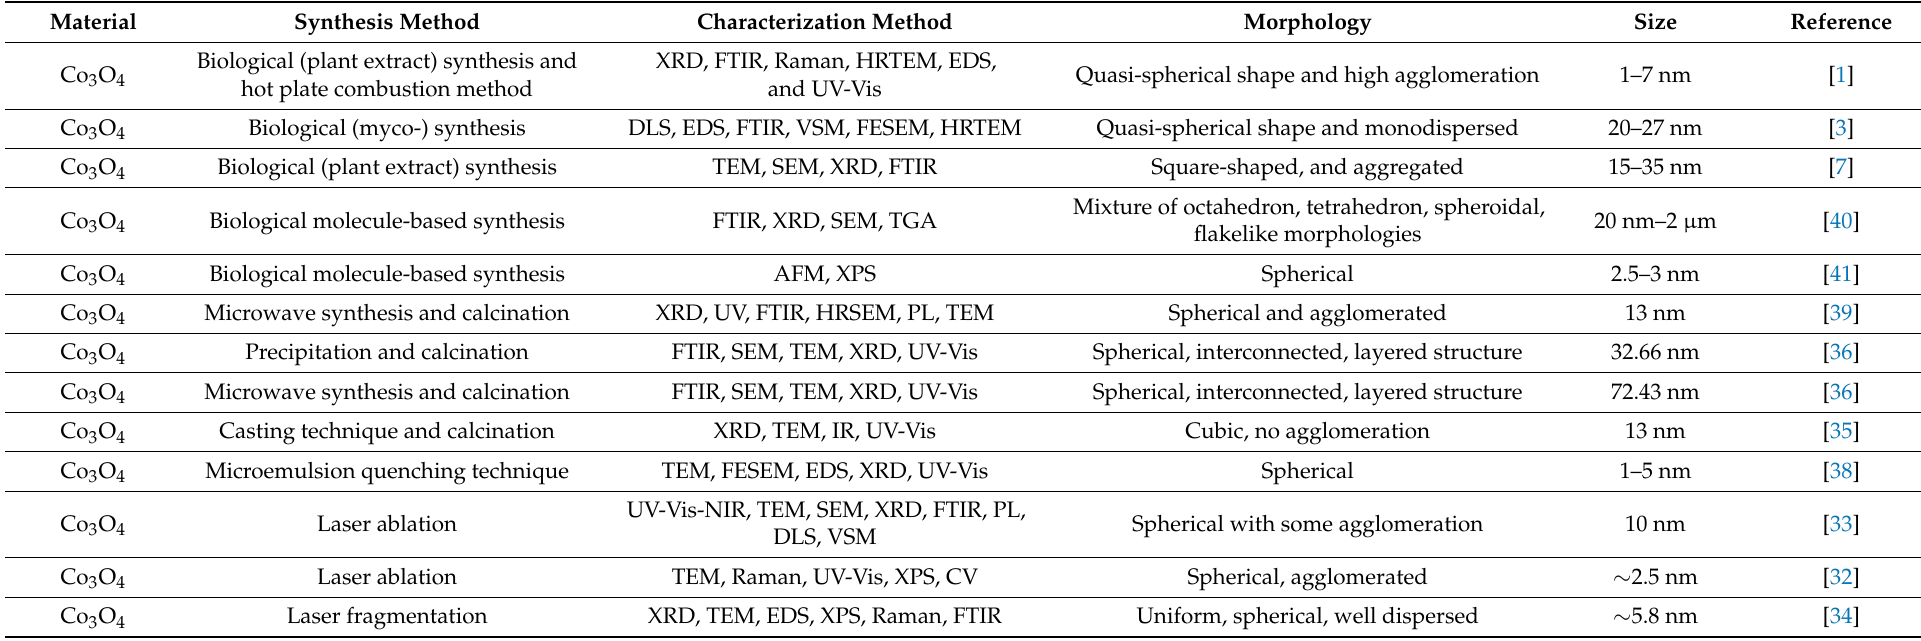
Table 1. Cobalt oxide nanoparticle synthesis, characterization, and